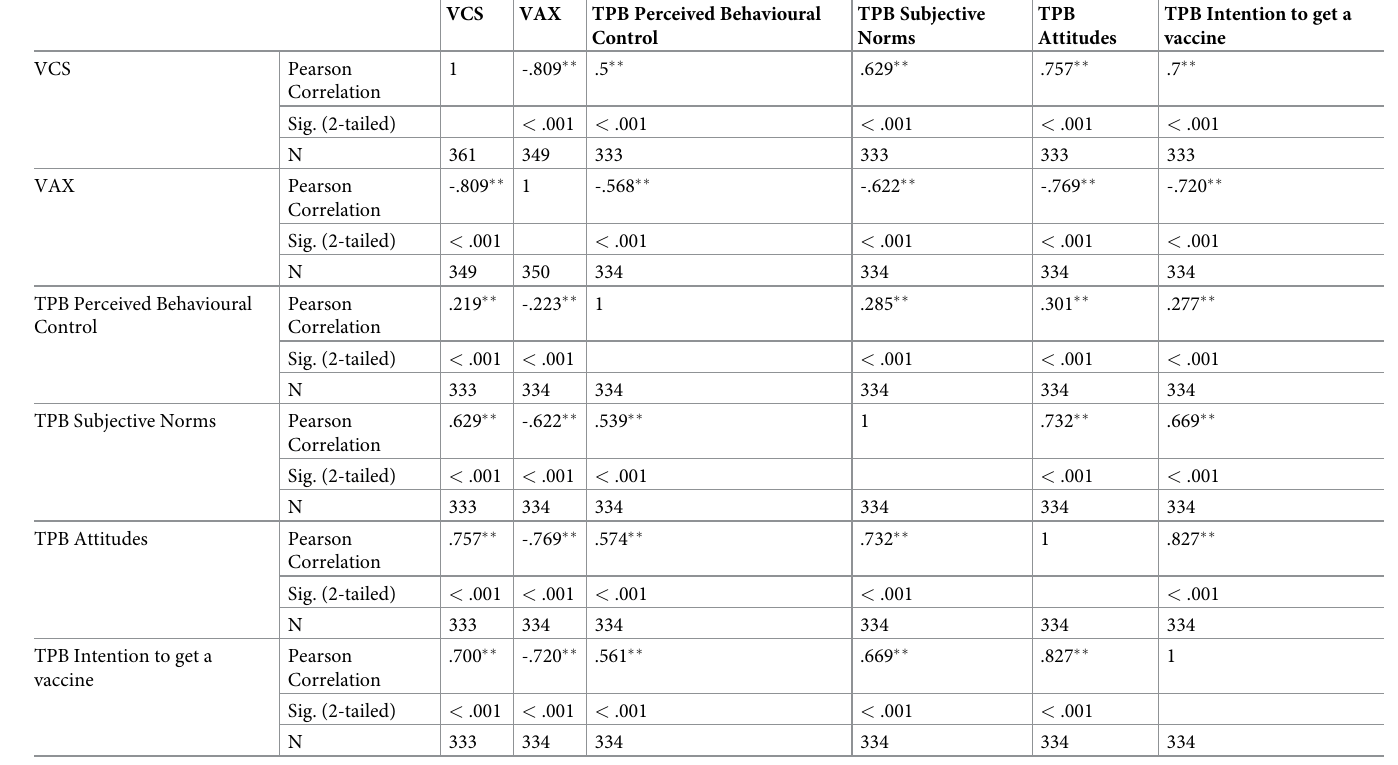
Table 3. Pearson product moment bivariate correlations between VCS, VAX and TPB scales.